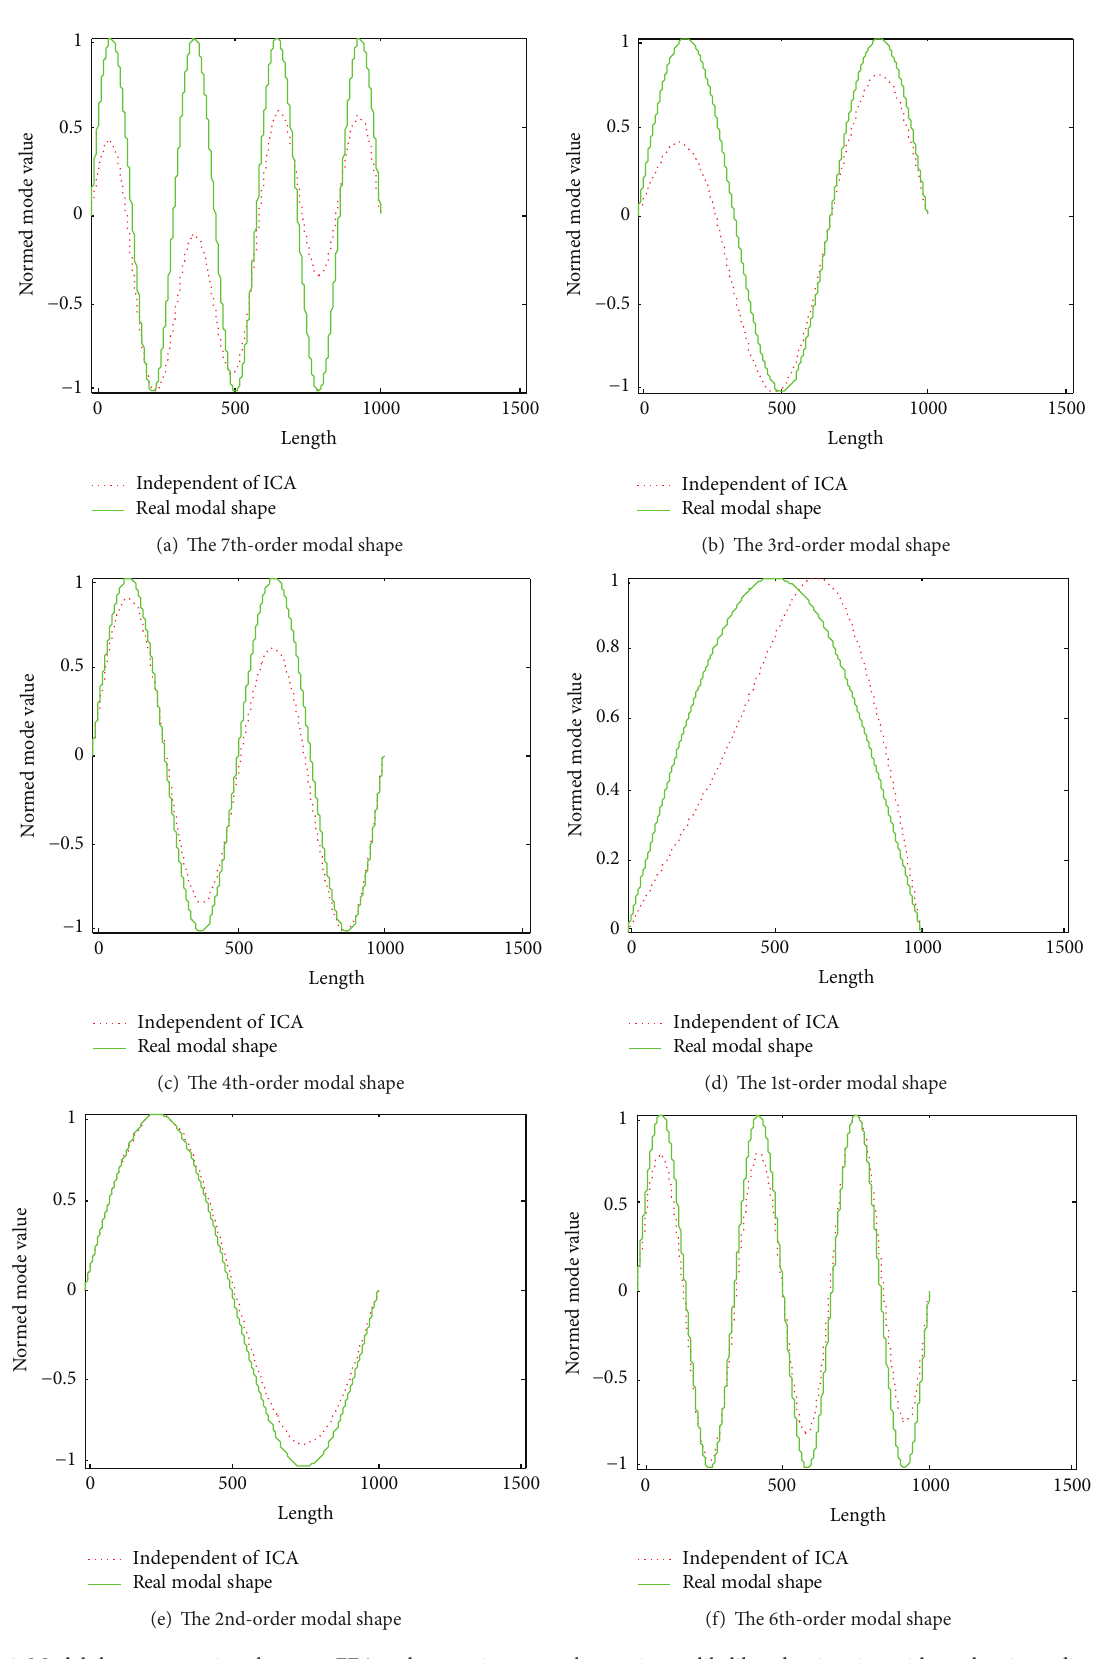
Figure 10: Modal shape comparison between FEA and separating vector by maximum likelihood estimation with stochastic gradient descent